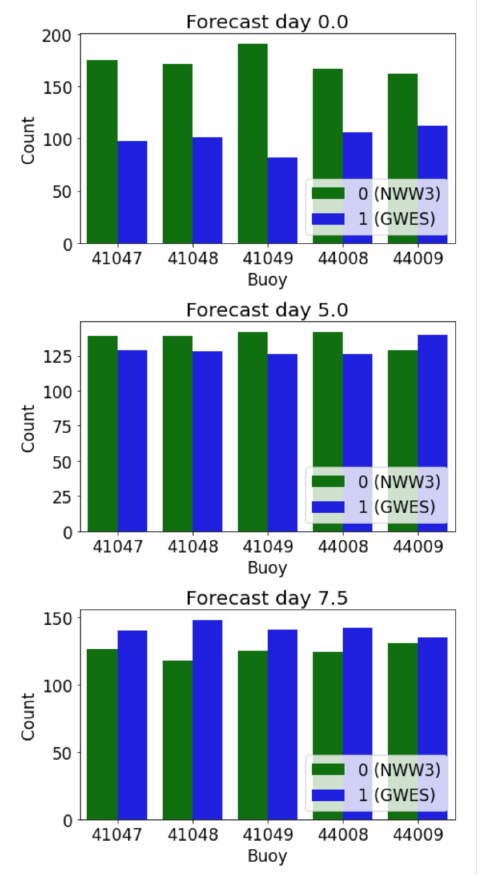
Figure 4. Proportion of the data in each class for the NDBC buoys for each forecast time. The x-axis shows the IDs of buoys, which can be visualized in Figure 1. The title of each plot indicates the forecast time associated.